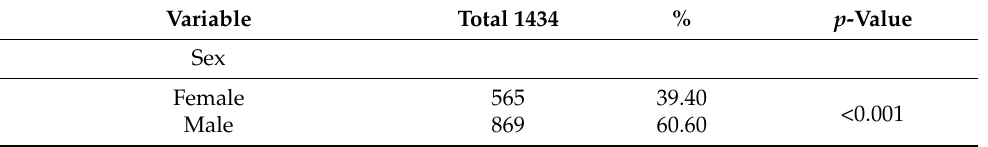
Table 1. Profile of tuberculosis cases in Ananindeua, Par á from 2018 to